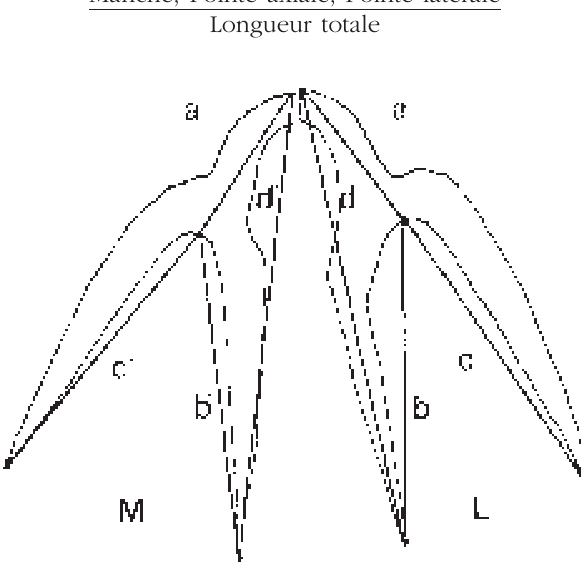
Fig. 1. – Mesures et nomenclature des crochets d’ Acanthobothrium . L : crochet latéral; M : crochet médian. a et a’ = longueur du